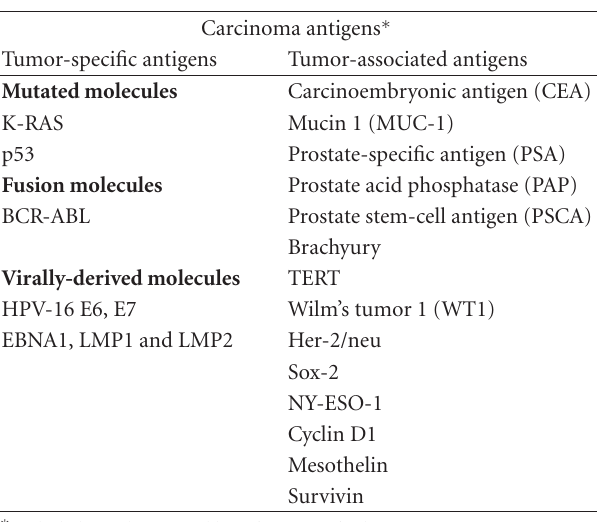
Table 2: Human carcinoma